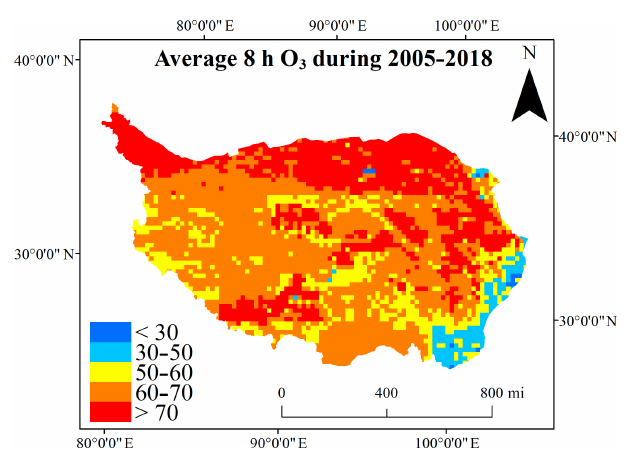
Figure 6. The mean value of estimated 8h O 3 concentration during 2005–2018 over the Tibetan